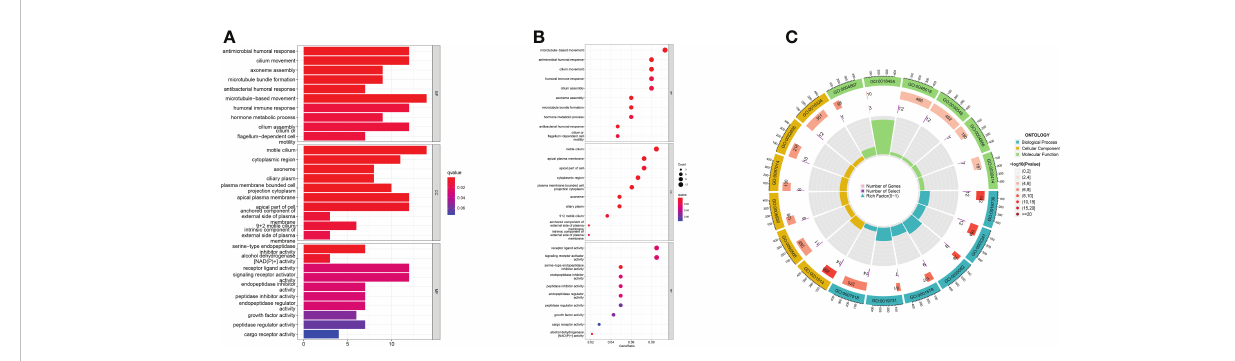
FIGURE 6 Focusing on the functional pathways of DEGs. (A) Bar chart (B) Bubble diagram (C) Circle diagram of GO enrichment